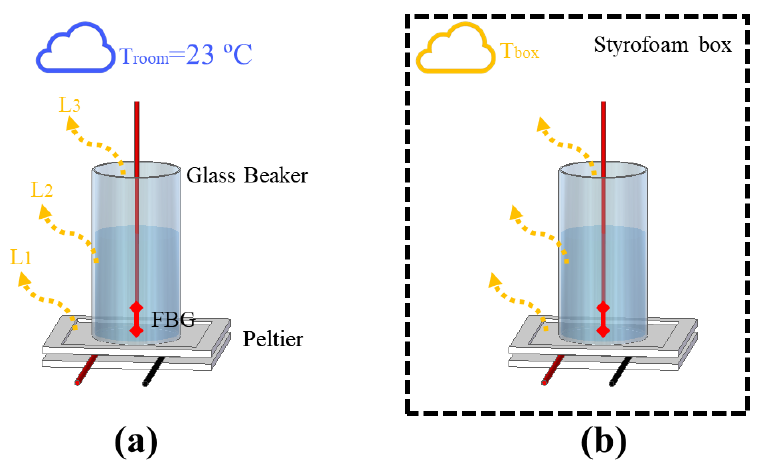
Figure 1. Experimental setup for the analysis of heat distribution, with ( a ) one not thermally insulated and ( b ) another using a styrofoam box to thermally insulate the